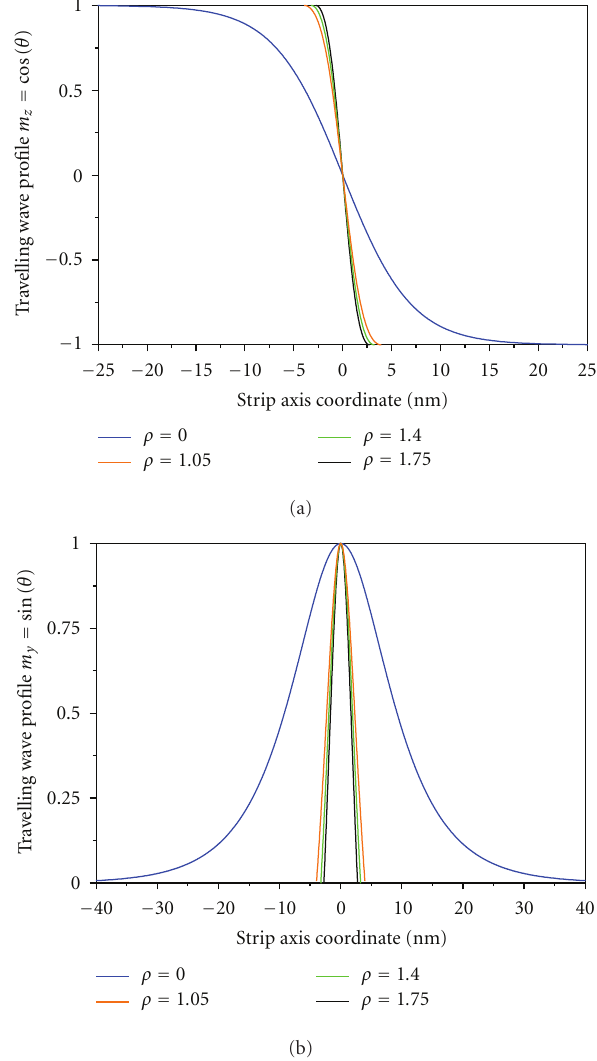
Figure 2: Comparison among the travelling wave profiles with and without Rashba field ( | ρ | > 1 and ρ = 0, resp.) computed analytically by using